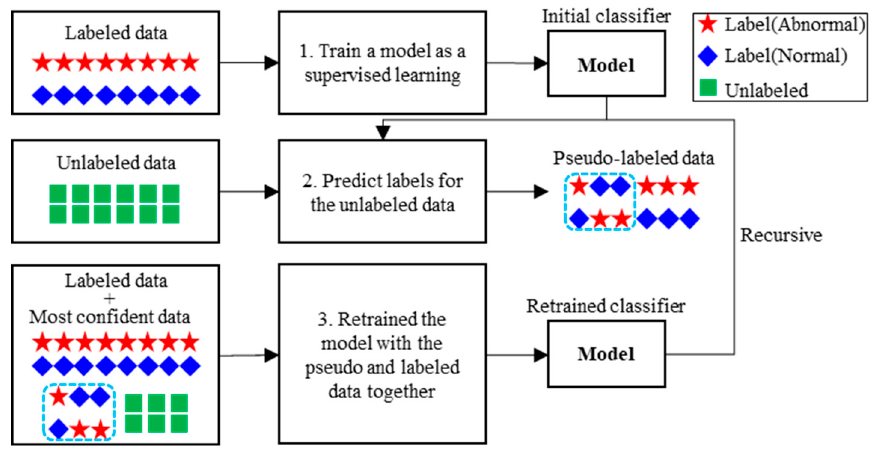
Figure 4. General framework of the self-training classifier.